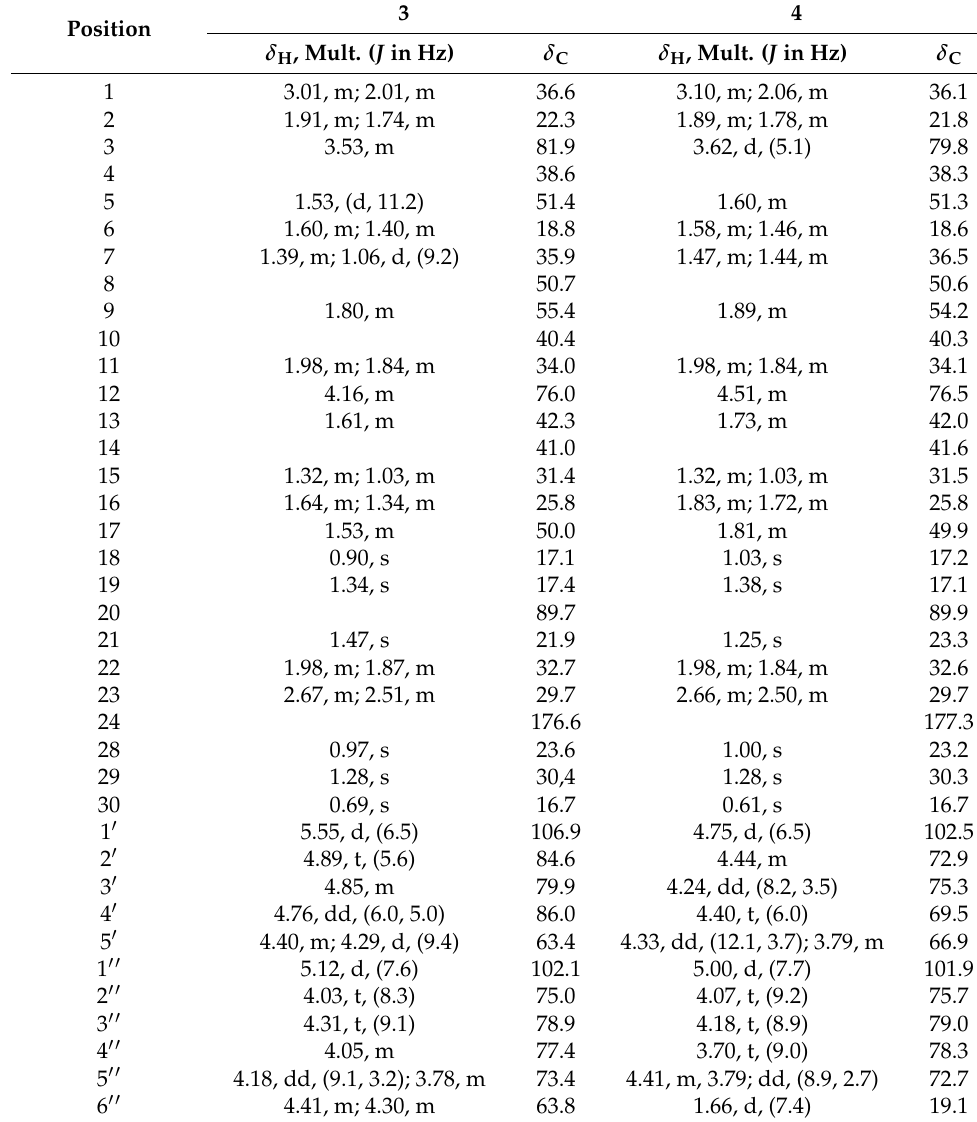
Table 3. 1 H and 13 C NMR spectral data of compounds 3 – 4 (600 MHz, pyridine- d 5 , δ in ppm). Position